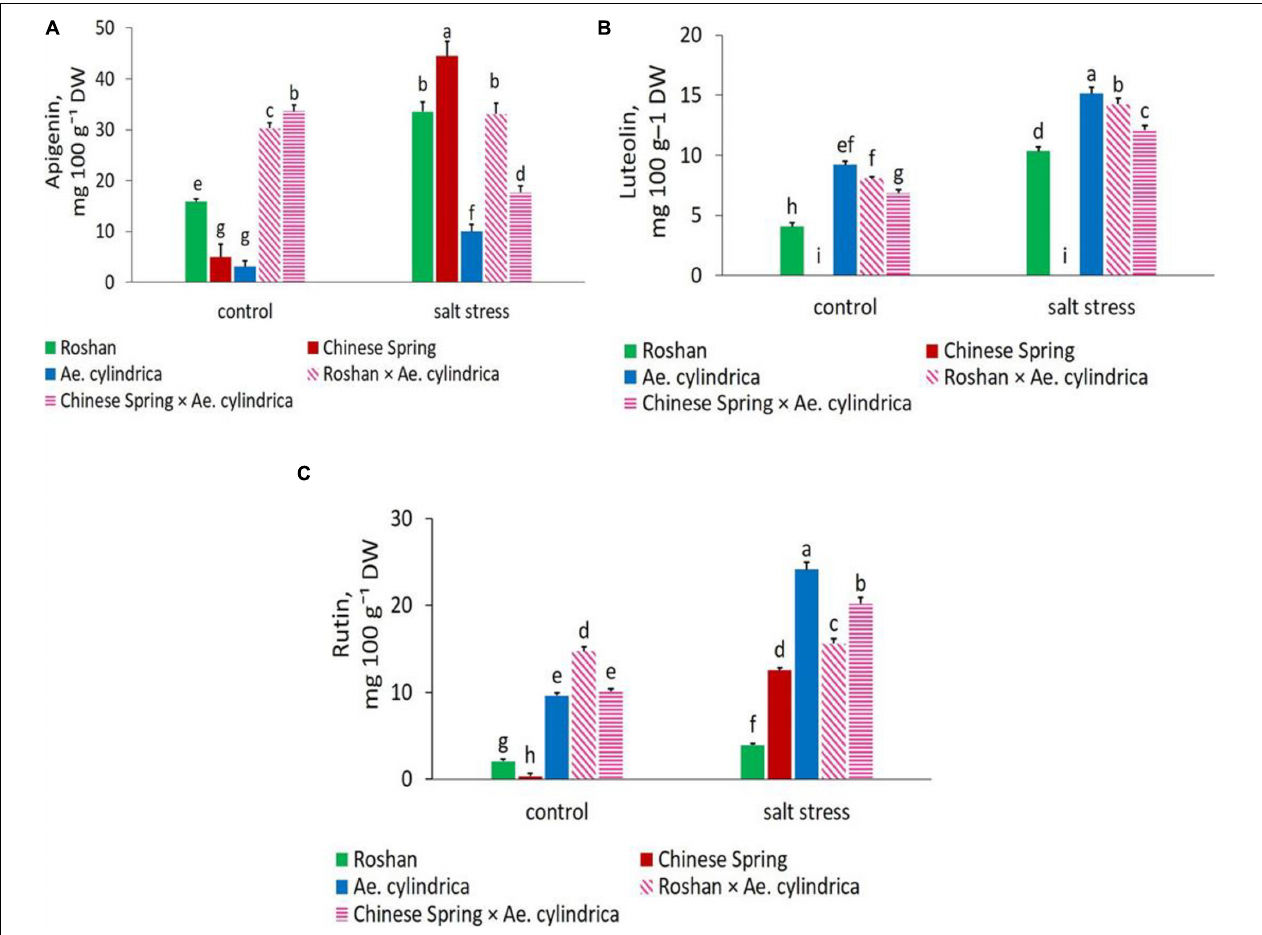
FIGURE 4 | Mean comparison of (A) apigenin, (B) luteolin, and (C) rutin of parents ( T. aestivum “Roshan,” “Chinese spring,” Ae. cylindrica ) and their F 1 hybrid plants (amphidiploids) under control and salt stress conditions. Bars represent means ± SE and bars with the same letter do not significantly differ at p < 0.05 among the genotypes.